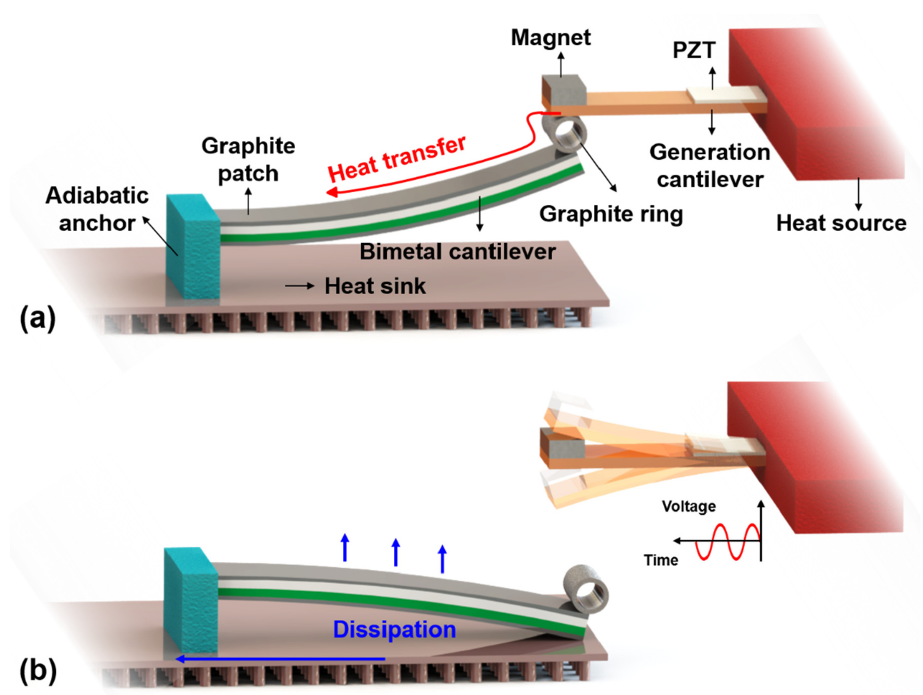
Figure 1. Schematic of the energy harvester for autonomous heat monitoring. ( a ) Endothermic state where the generation cantilever and the bimetallic cantilever are attracted; ( b ) exothermic state where the bimetallic cantilever and the generation cantilever are separated, and the freed generation cantilever is vibrating and generating electricity.